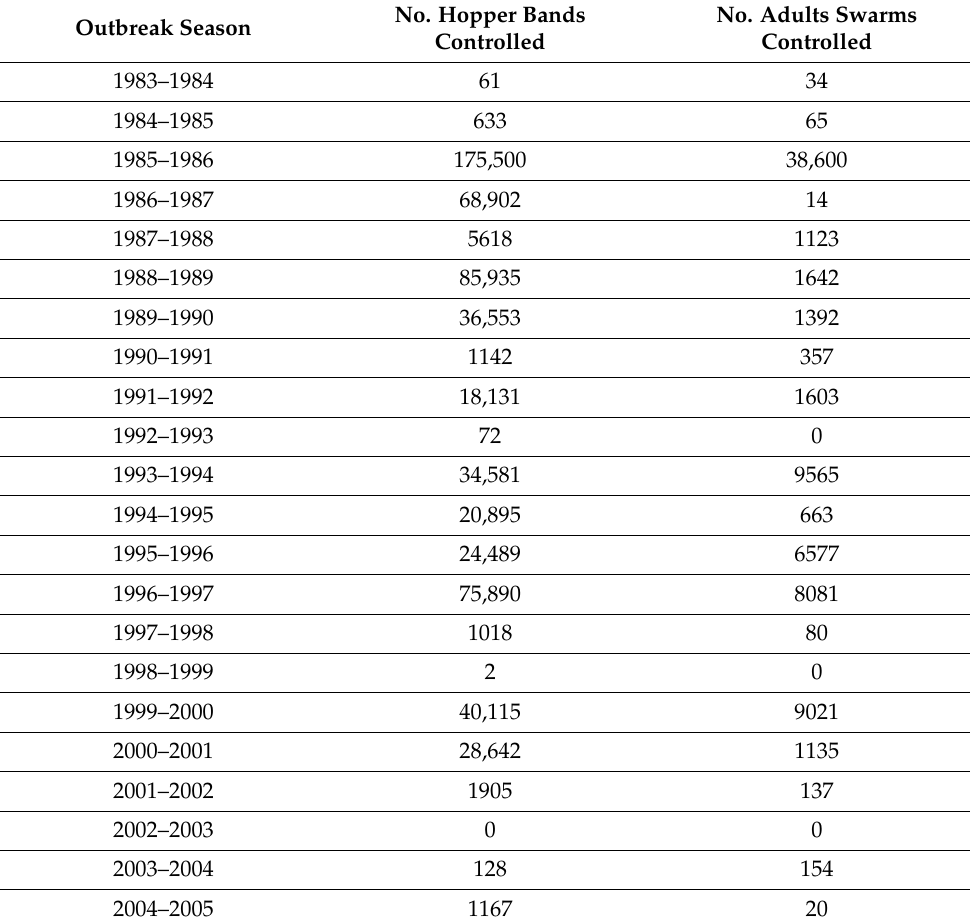
Table 1. The number of individual locust targets (roosting hopper bands and adult swarms) controlled during each outbreak season (September to June) in South Africa between 1983–1984 and 2004–2005 (data from the weekly reports of the locust control officers of the South African National Department of